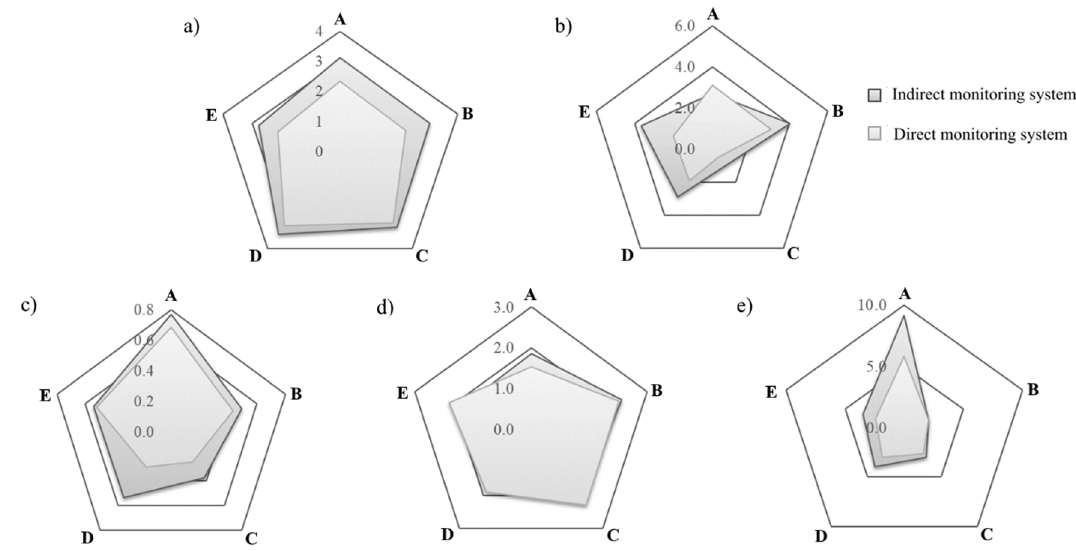
Figure 3. Radar graph showing ( a ) the distribution of biomass [g] growth in A. bisporus in vitro cultures, and the accumulation of ( b ) Mg, ( c ) Zn, ( d ) Cu, ( e ) Fe [mg/g] in biomass obtained from A. bisporus in vitro cultures depending on the system of monitoring the composition of the medium (A, B, C, D, E—symbol identify in vitro culture—according to Table 2).